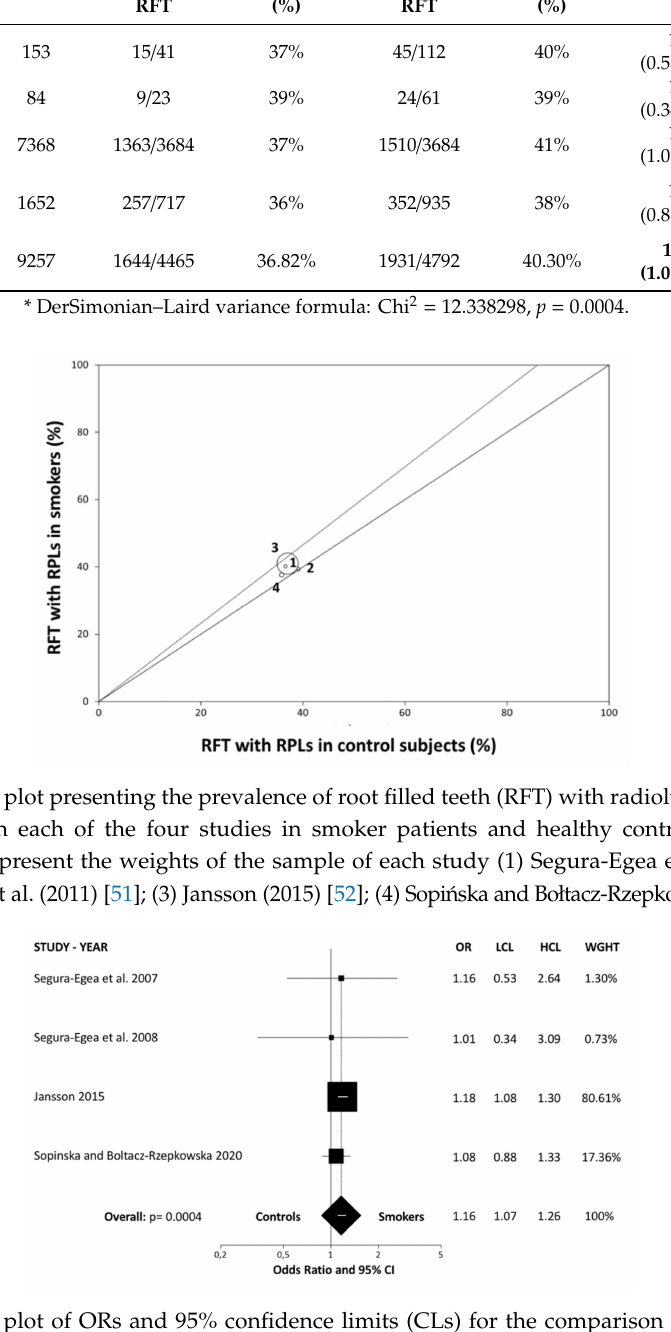
Table 3. Studies about smoking habits and the prevalence of root filled teeth (RFT) with radiolucent periapical lesions (RPLs). Results extracted and compiled, descriptive statistics, and calculated odds ratios. Authors / Ref.